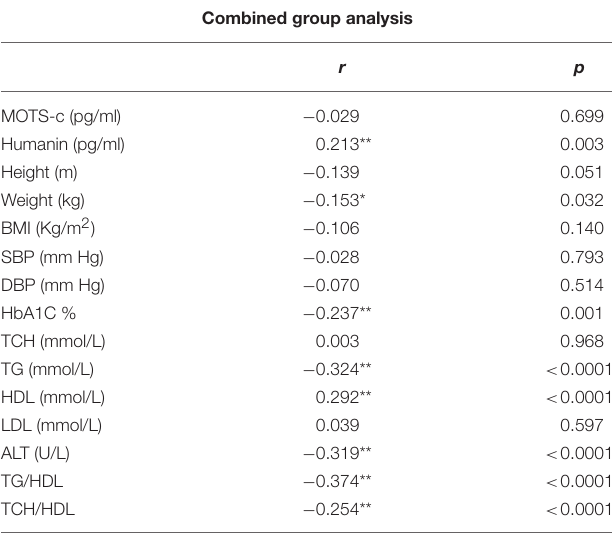
TABLE 2E | Spearman Rank correlation bivariate analysis of variables associated with ADP. Combined group analysis